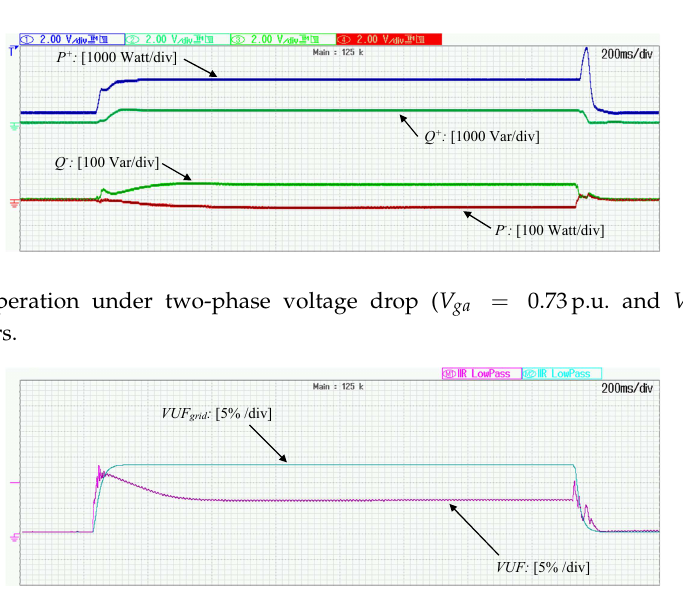
Figure 10. Operation under two-phase voltage drop ( V ga = 0.73p.u. and V gc = 0.65p.u.): Voltage unbalance